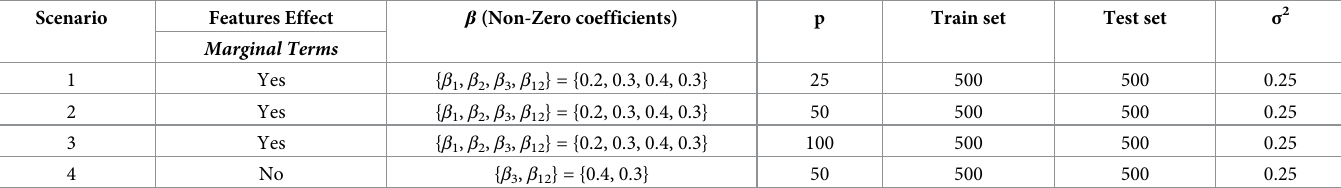
Table 1. Description of the simulation data.